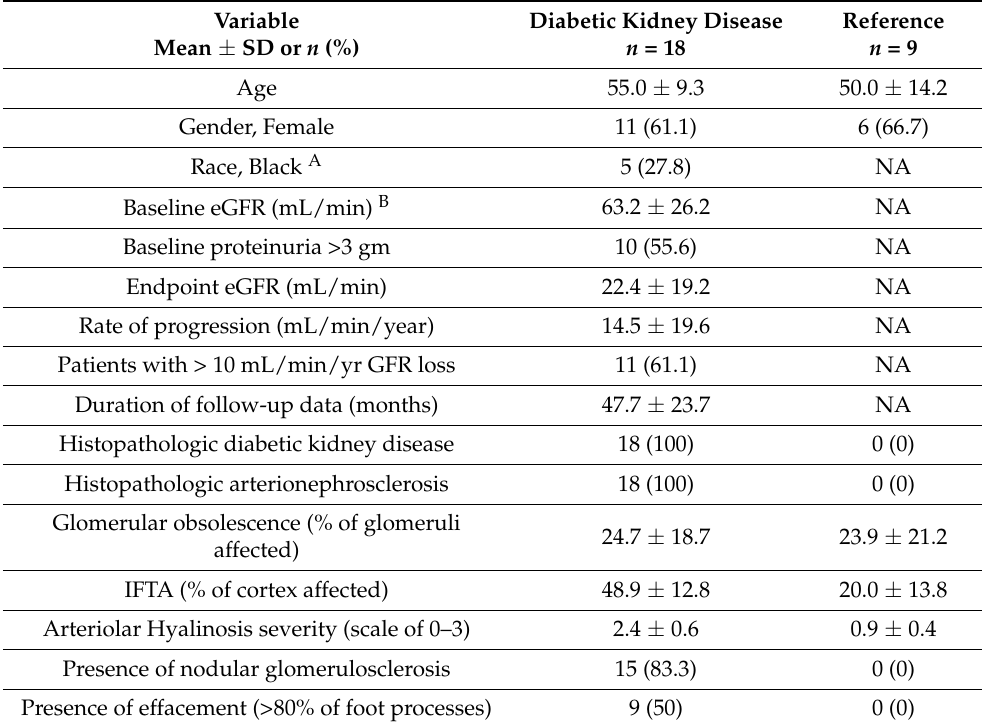
Table 1. Summary clinical characteristics of